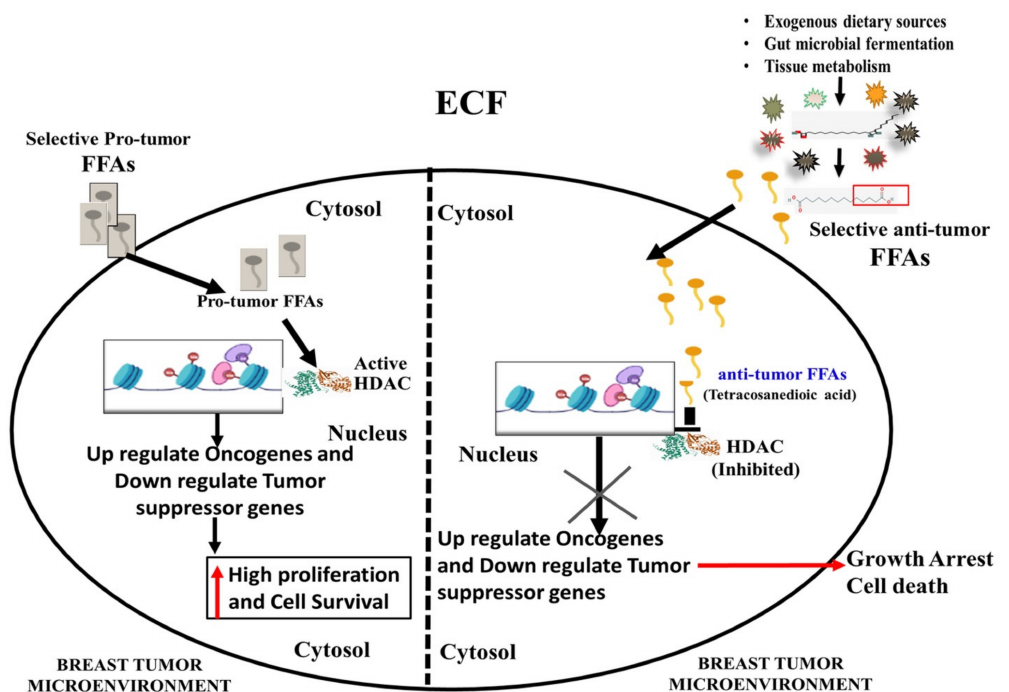
Figure 11. A proposed model of the potential antiproliferative and apoptotic role of FFAs in cancer cells. FFAs, free fatty acids; ECF, extracellular fluid; HDAC, histone deacetylase; FATP, fatty acid translocase